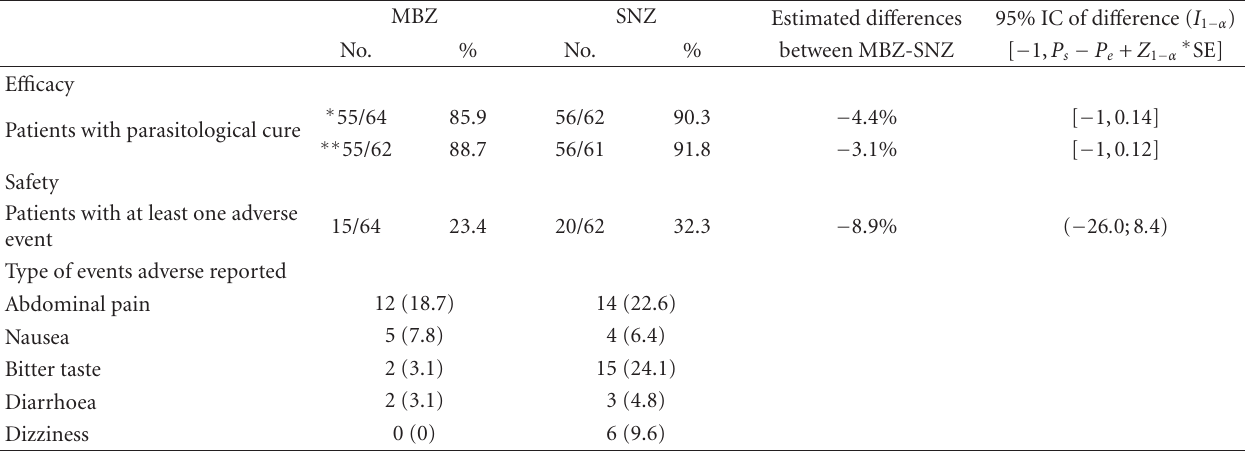
Table 2: Parasitological response and adverse events reported after